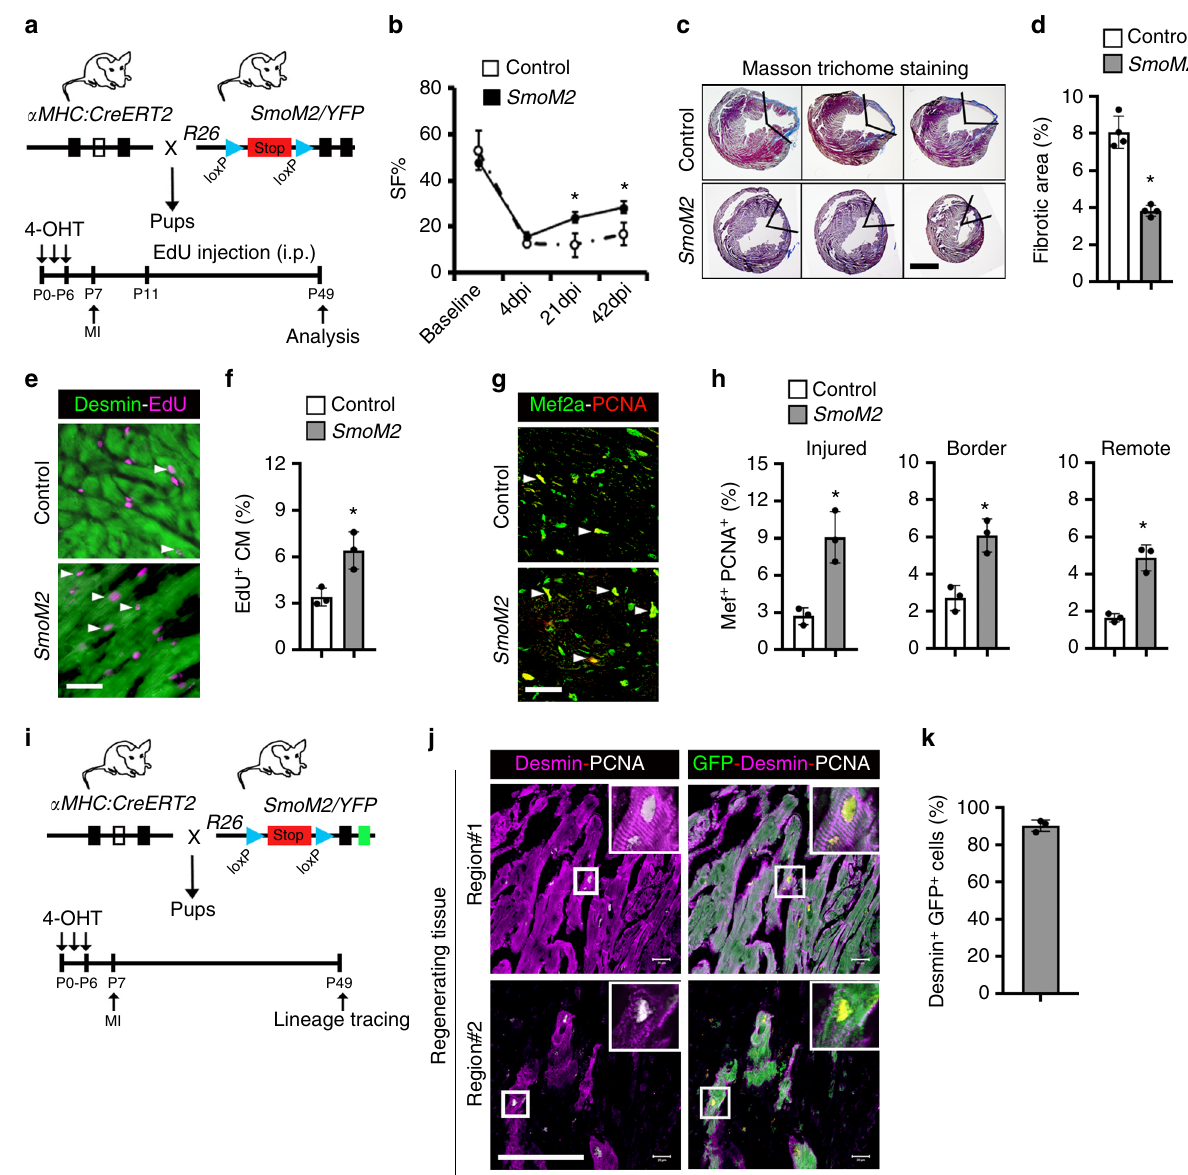
Fig. 6 Activated Smoothened ( SmoM2 ) augments heart regeneration by promoting proliferation of pre-existing cardiomyocytes during the non-regenerative period. a Schematic outlining the experimental design for Smo activation (SmoM2) and cardiac regeneration analysis following myocardial injury. b Time series echocardiographic measurement of shortening fraction (SF%) of control and SmoM2 mice following MI ( n = 4 per group). c , d Masson trichrome staining ( c ) and fi brotic area quanti fi cation ( d ) of representative heart sections at 42 days postinjury from control and SmoM2 hearts ( n = 4 for each group). e , f Immunostaining ( e ) and quanti fi cation ( f ) of Desmin + -EdU + cardiomyocytes in control and SmoM2 hearts. Arrowheads indicate EdU + labeled cardiomyocytes. g , h Immunostaining ( g ) and quanti fi cation ( h ) of Mef2a + -PCNA + cardiomyocytes in injured, border, and remote areas from control and SmoM2 hearts ( n = 3 for each group). Arrowheads indicate PCNA + -cardiomyocytes. Quantitative analysis represents counting three random fi elds at